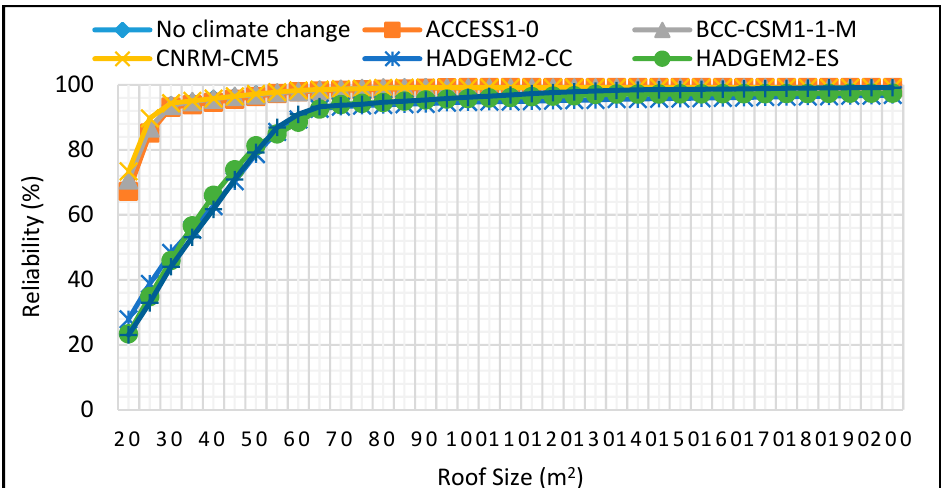
Figure 30. Reliability projections for MAM season for 5 m 3 tank size for 2060–2090 period.